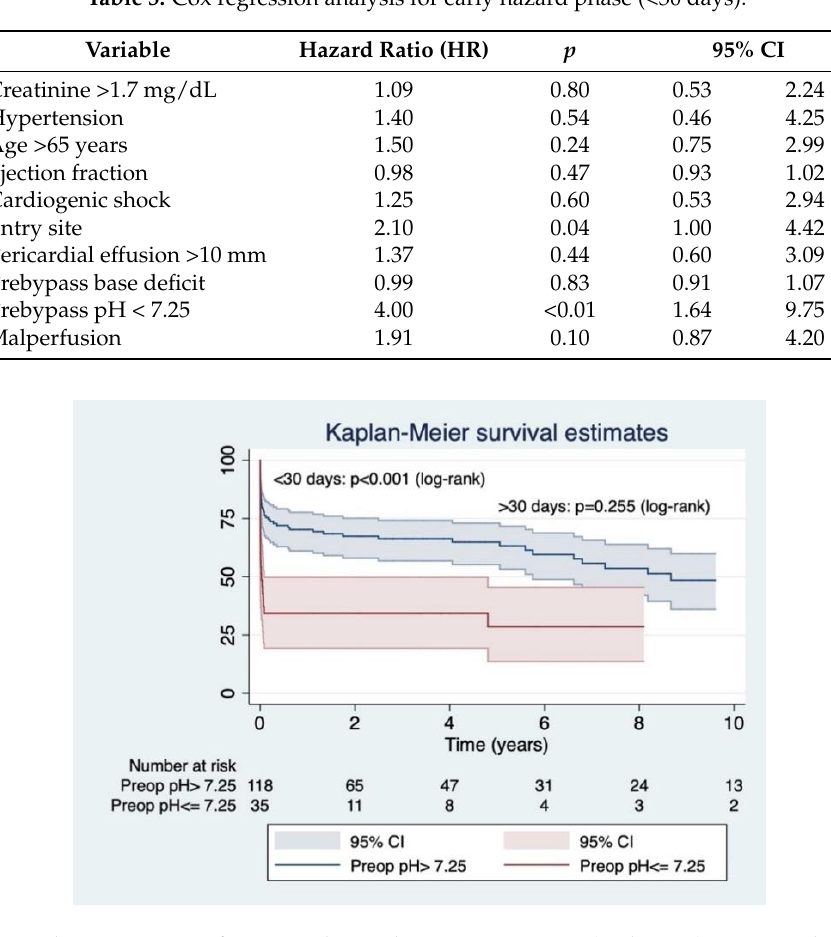
Figure 3. Kaplan–Meier curve for survival according to preoperative (prebypass) pH. A pH lower than 7.25 severely impacts early survival, but long-term (>30 days) survival is determined by other